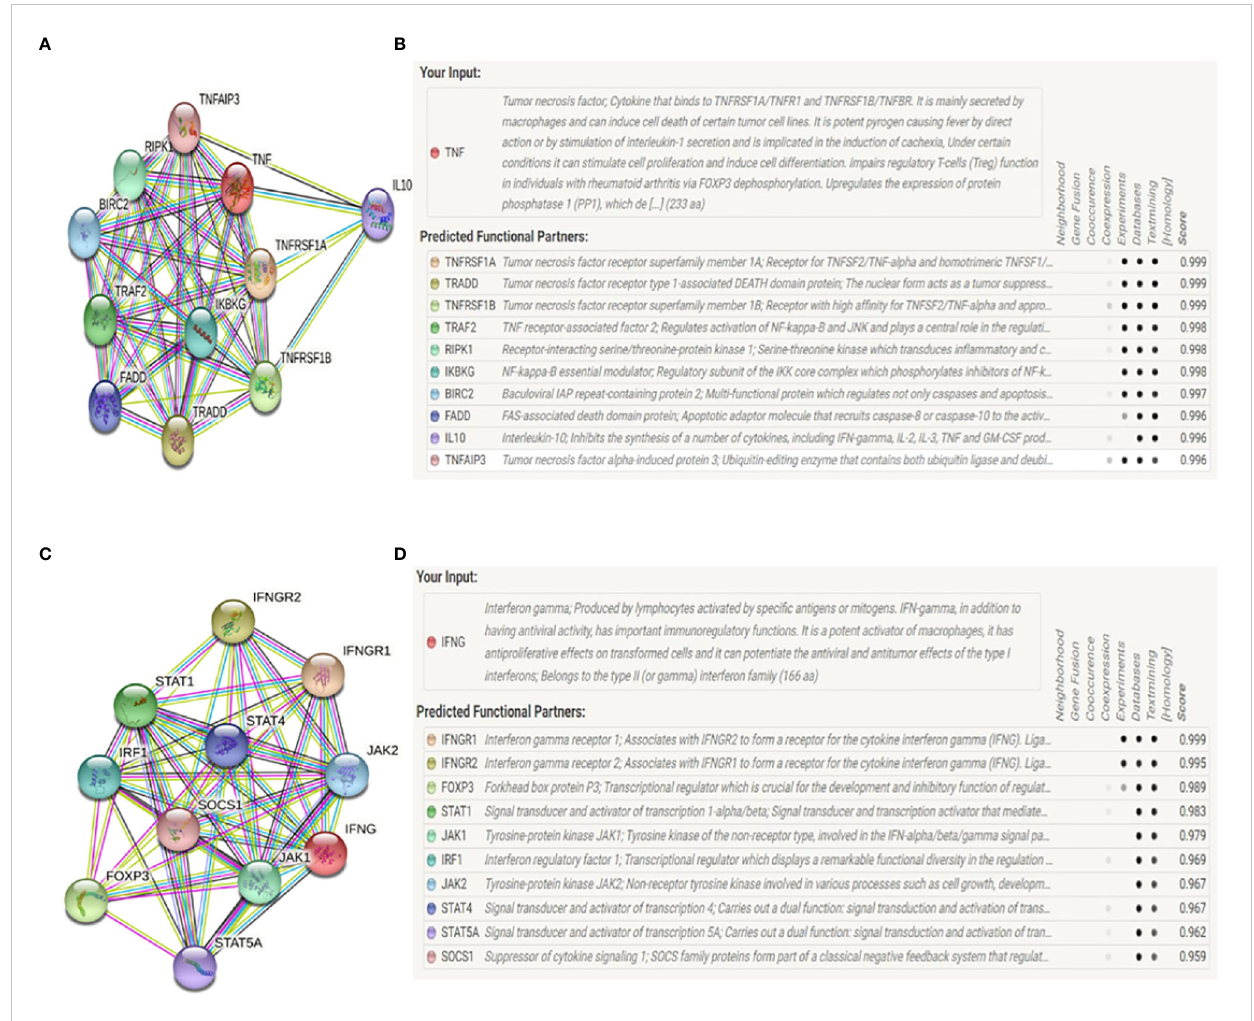
FIGURE 8 STRING network diagrams depicting interactions between human TNF- a or IFN- g and other genes. (A, B) . At least 10 genes were correlated with: TNFRSF1A: tumor necrosis factor receptor superfamily member 1A; TNFRSF1B: tumor necrosis factor receptor superfamily member 1B; TRADD: tumor necrosis factor receptor type 1-associated DEATH domain protein; TRAF2: TNF receptor-associated factor 2; RIPK1: receptor-interacting serine/threonine-protein kinase 1; FADD: FAS-associated death domine protein; IKBKG: NF-kappa-B essential modulate; BIRC2: baculoviral IAP repeat-containing protein; IL-10: interleukin-10; TNFAIP3: tumor necrosis factor alpha-induced protein 3. (C, D) . At least 10 genes were correlated with: IFNGR1: IFN- g receptor 1; IFNGR2: IFN- g receptor 2; FOXP3: forkhead box protein P3; JAK1: tyrosine-protein kinase JAK1; JAK2: tyrosine- protein kinase JAK2; IRF1: interferon regulatory factor 1; STAT1: signal transducer and activator of transcription 1-alpha/beta; STAT4: signal transducer and activator of transcription 4; STAT5A: signal transducer and activator of transcription 5A; SOCS1: suppressor of cytokine signaling